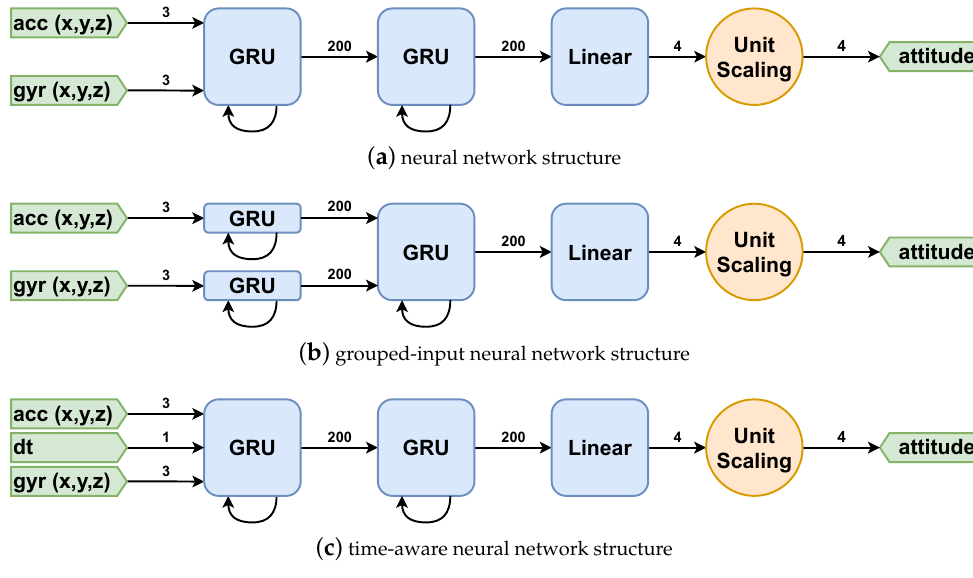
Figure 2. The structure of the neural network ( a ); the grouped-input neural network ( b ) with separate layers for accelerometer and gyroscope; and the time-aware neural network ( c ) with the time-difference as an additional input for attitude